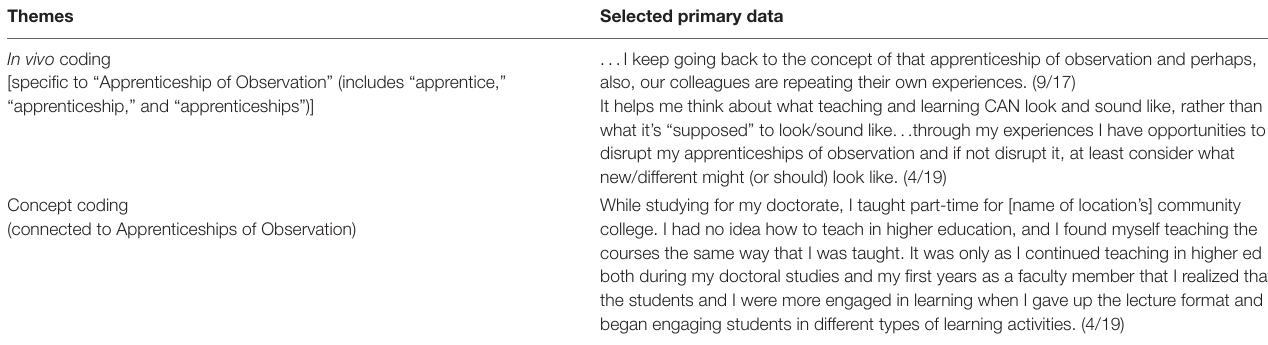
TABLE 5 | In vivo and concept coding examples. Themes Selected primary